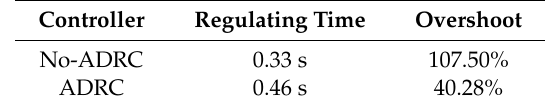
Table 4. Simulation results of output power.